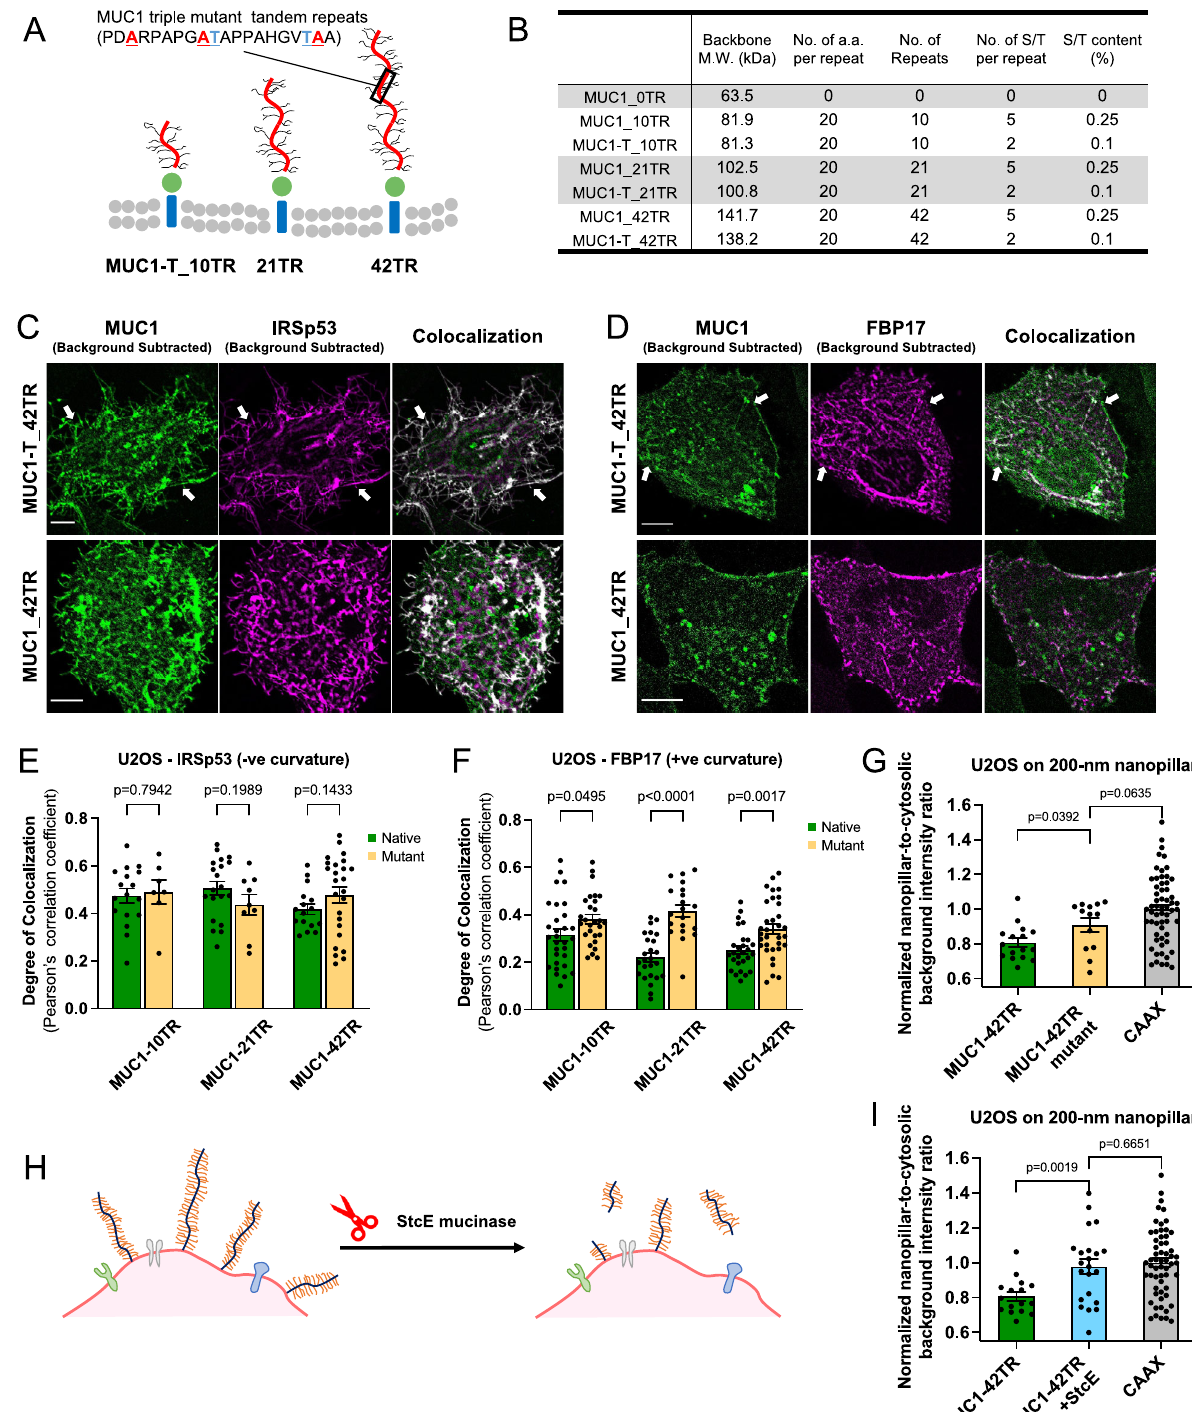
MUC1 ’ s avoidance of positively-curved membranes delays its removal from the plasma membrane . The generation of positive membrane curvature is an essential feature of endocytosis. We hypothesize that MUC1 ’ s avoidance of positive membrane cur- vature may impede its removal from the plasma membrane through endocytosis. For this purpose, we compared the endo- cytosis levels of MUC1 with different sizes of ectodomains (MUC1_0TR-GFP, MUC1_10TR-GFP, and MUC1_42TR-GFP). MUC1 endocytosis was probed by fi rst incubating transfected